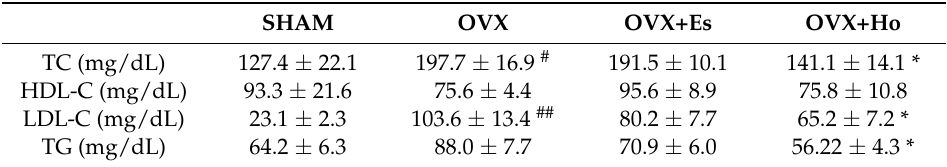
Table 1. Serum blood parameter in OVX induced dyslipidemia. TC; total c, TG; triglycerides, HDL-C; high-density lipoprotein cholesterol, LDL-C; low-density lipoprotein. Values are given as means ± SEM.